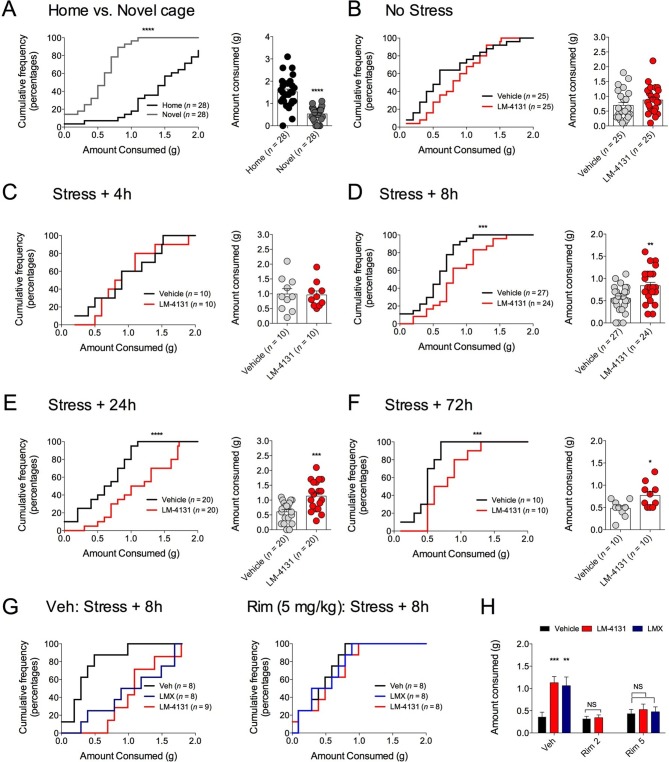
Effects of COX-2 inhibition on food consumption in the NIH test.(A) Cumulative distribution curves depicting proportion of mice consuming a given amount of food, and mean consumption amounts in the home cage and novel cage setting. (B–F) Effects of LM-4131 on Ensure consumption compared to vehicle treatment under control (non-stressed) conditions (B), 4 hr (C), 8 hr (D), 24 hr (E), and 72 hr (F) after foot-shock stress. (G–H) Effects of Vehicle, LM-4131 or Lumiracoxib on consumption in the presence of vehicle or Rimonabant (2 or 5 mg/kg) co-treatment. In bar graphs *p<0.05, **p<0.01, ***p<0.001 by unpaired two-tailed t-test (B–F) or by Holm-Sidak multiple comparisons test (G). For cumulative frequency distributions, ***p<0.001, ****p<0.0001 by K-S test.